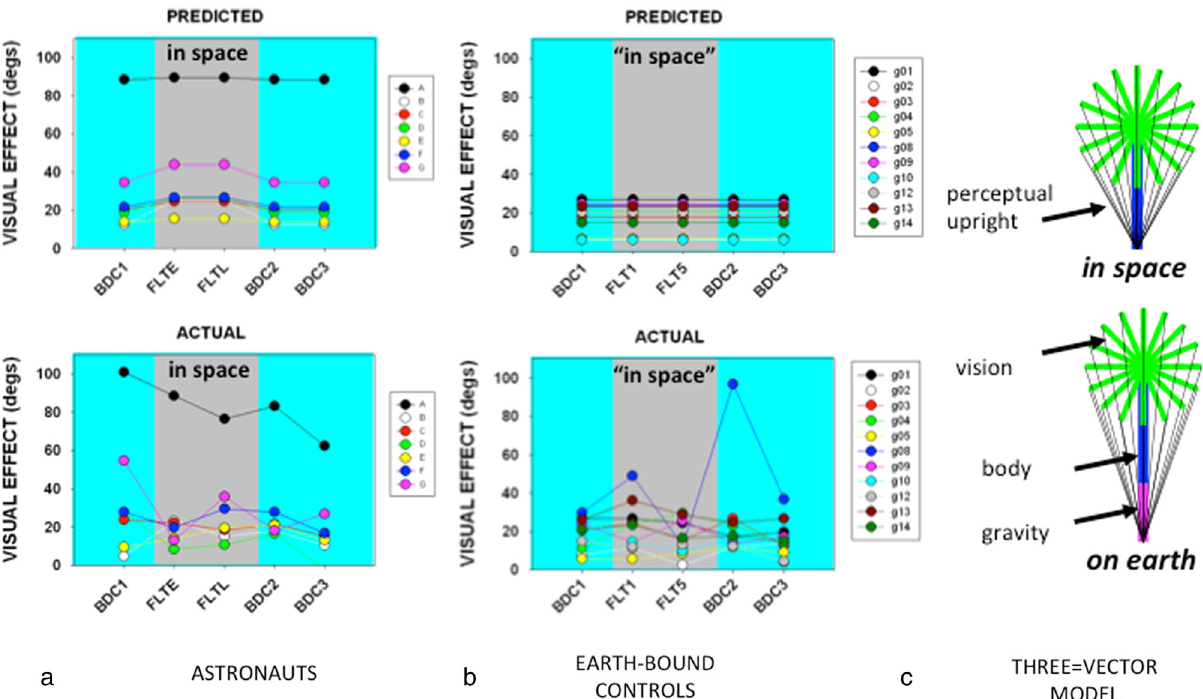
Fig. 5 The size of the visual effect for each astronaut ( a , lower panel ) and ground control ( b , lower panel ) is compared to the effect that would be predicted if the relative weights of vision and body remained constant ( upper panels ). The gray shaded region indicates the measurements taken in space (or at equivalent times for the controls). FLTE and FLTL refer to measurements taken early (9 – 14 days) and late (77 – 190 days) in fl ight, or at the equivalent times (FLT 1 and FLT 5) for the controls. The three-vector model is shown diagrammatically in c to illustrate